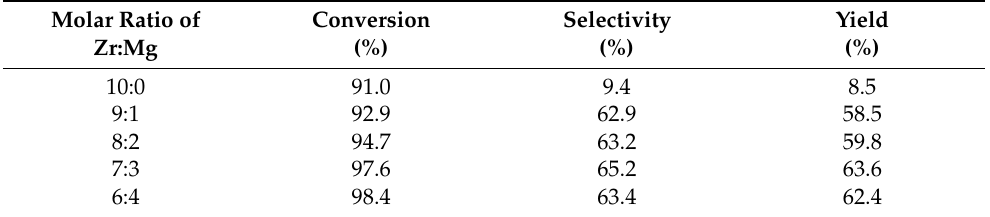
Figure 7. The histograms of the PC yield for CO 2 /PO cycloaddition reactions using the Zr–Mg mixed oxide aerogels with different Zr/Mg molar ratios. Table 2. The PO conversion, PC selectivity, and PC yield using the Zr–Mg mixed oxide aerogels with different Zr/Mg molar ratios.